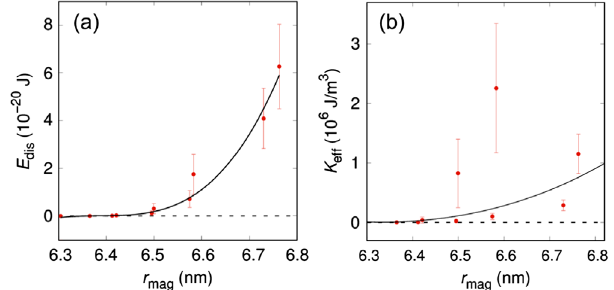
FIG. 7. Dependence of (a) disorder energy E the coherent magnetic particle radius (black line, spline fit of the data) and (b) the effective disorder energy density K derivative of spline in